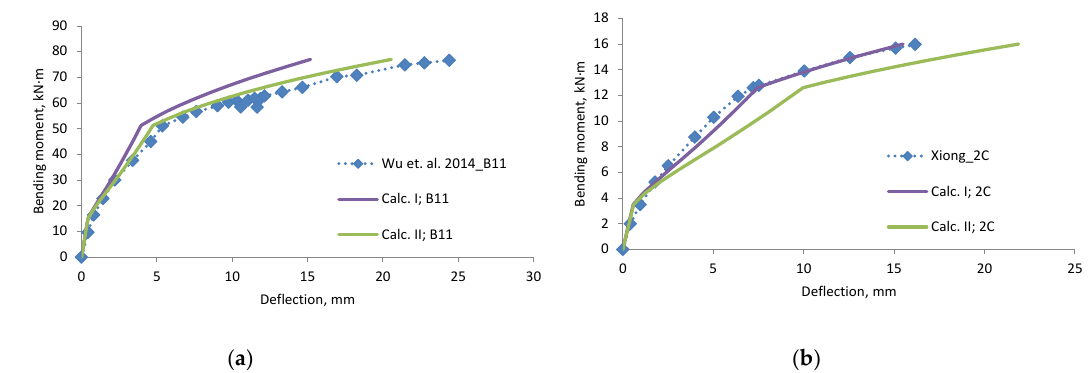
Figure 9. Bending moment–deflection curves, ( a ) beam B11; ( b ) beam 2C.